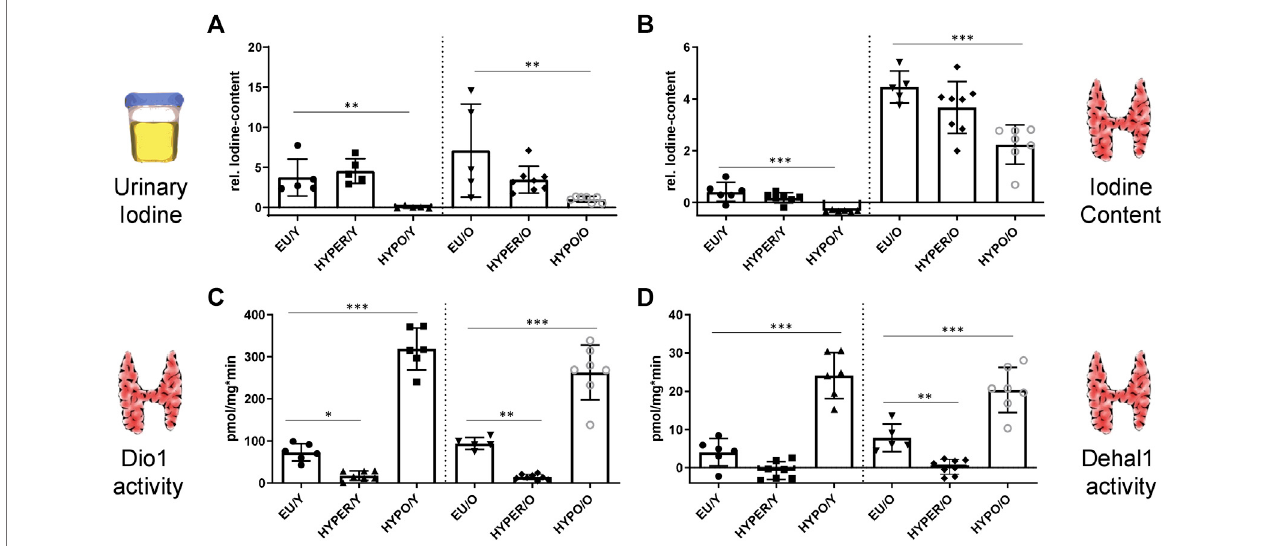
FIGURE 1 | UrineiodineandthyroidalDio1,Dehal1andI-contentisaffectedbyHYPERandHYPOtreatment; (A) Asamarkerofiodineintakeandretention,spontaneous urine from mice is digested and measured for relative iodine content, showing reduced levels in the HYPO-group fed with iodine-de fi cient diet. (B) Iodine content of thyroids is stronglyelevatedinagedmicecomparedtoyoungonesandreducedintheHYPO-groups,independentofage. (C,D) ThyroidalDio1andDehal1activitiesaredecreased(HYPER) and increased (HYPO) compared to the control groups (EU), independent of age. [young groups (Y) on the left, old groups on the right (O)] All measurements used the Sandell-Kolthoff-reaction as readout. Signi fi cance is tested by ANOVA test followed by Bonferroni ’ s test. ( n = 5 – 8/group); * p ≤ 0.05, ** p ≤ 0.01, *** p ≤ 0.001.